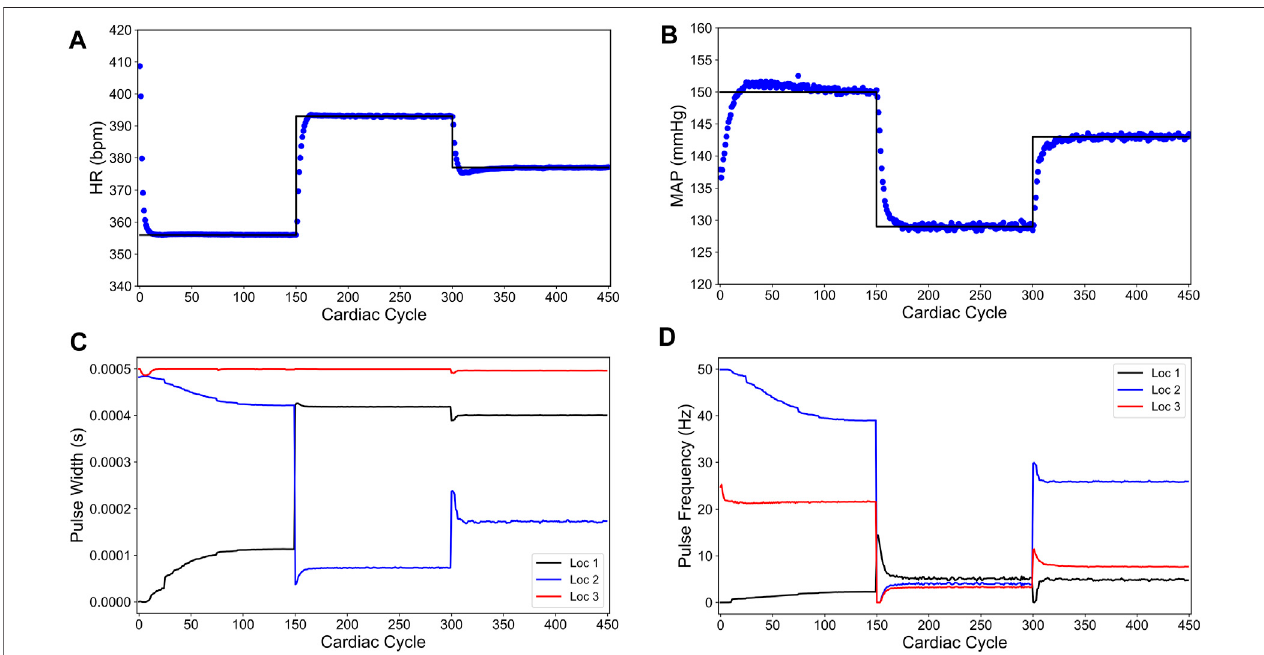
FIGURE 8 | Offset-free closed-loop control of the heart rate (HR) and the mean arterial blood pressure (MAP) of the modi fi ed in silico physiological model of the rat cardiac system in the presence of intra-patient variability in the VNS response to HR and MAP. (A) and (B) show the closed-loop control response from the modi fi ed in silico physiological model (shown in blue dots) and the target (or reference) for the controller (shown in black line) for HR and MAP, respectively. (C) and (D) show the pulse width and the stimulation frequency, respectively, designed by the controller at each VNS location.